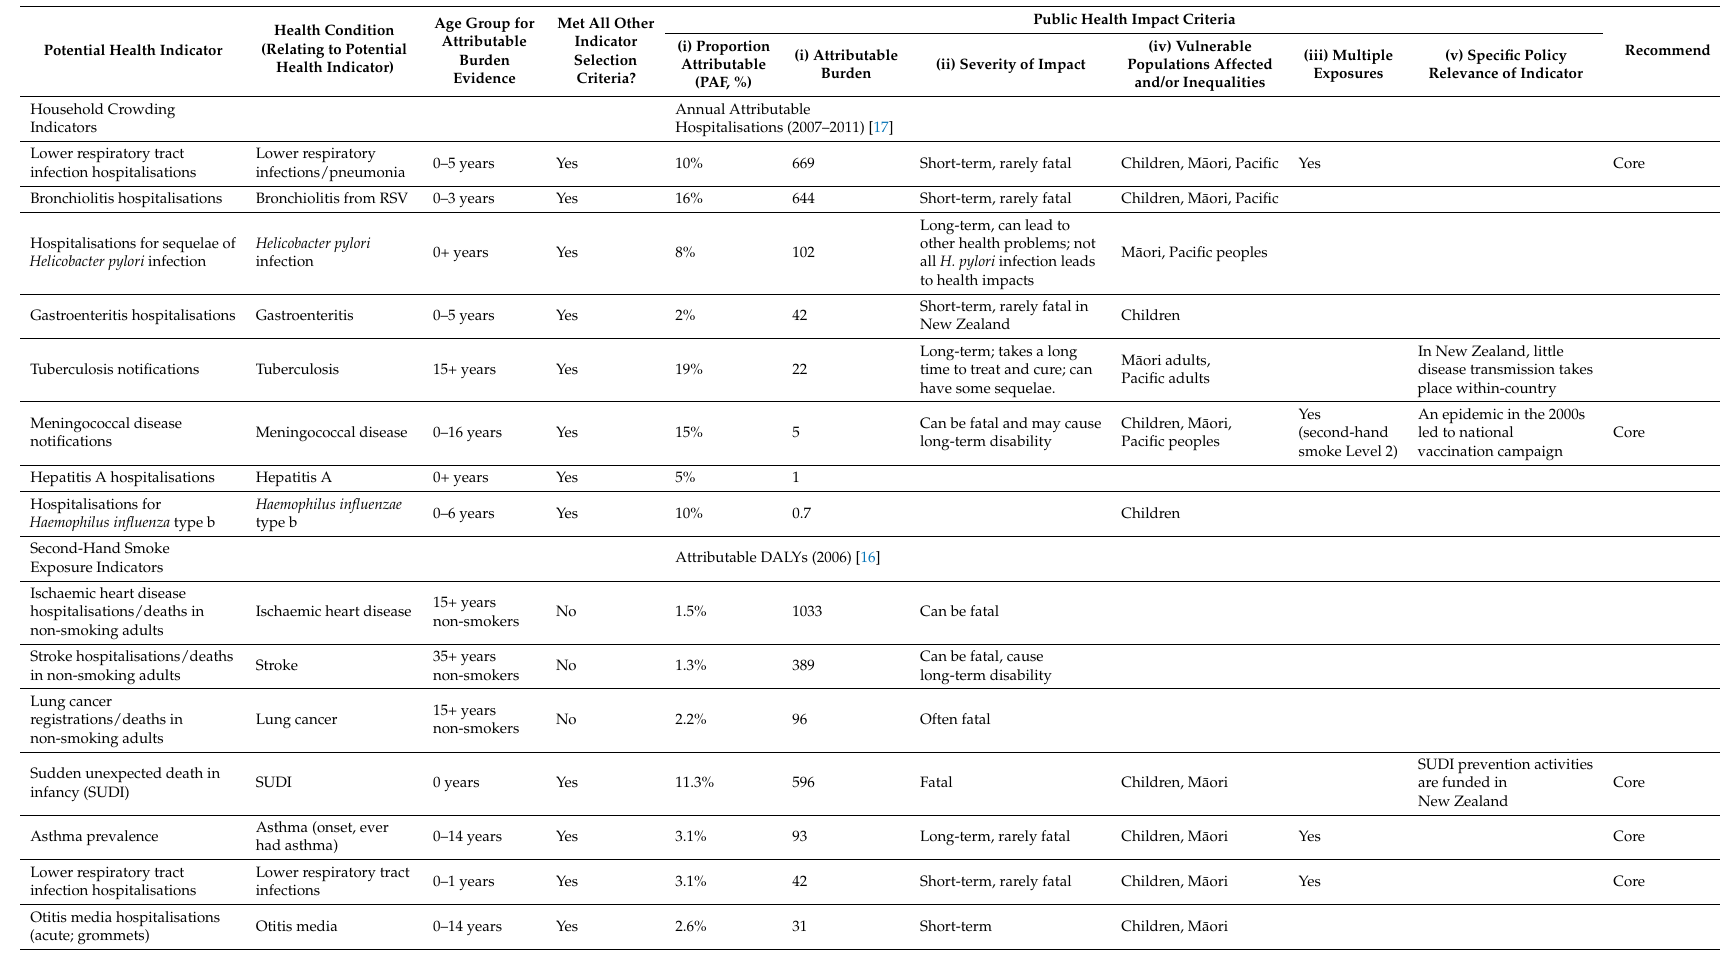
Table 5. Assessment of health indicators for indoor environment, by public health impact